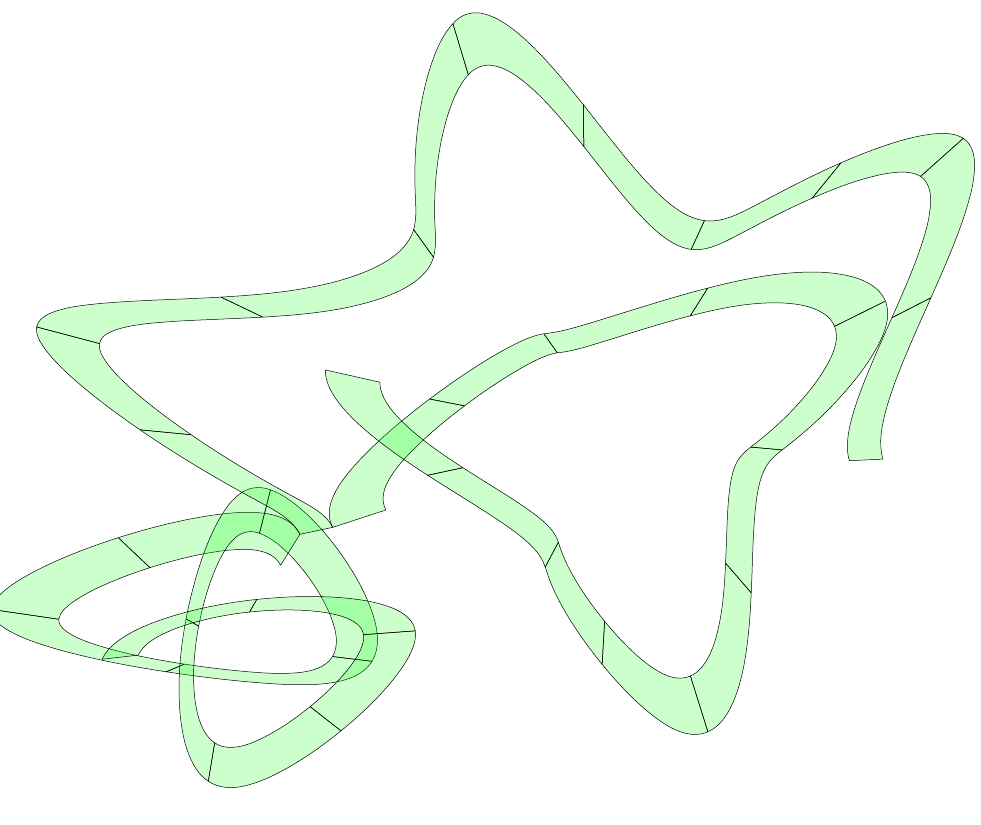
Figure 26. Sculpture in the form of a trefoil knot, unrolled panels.